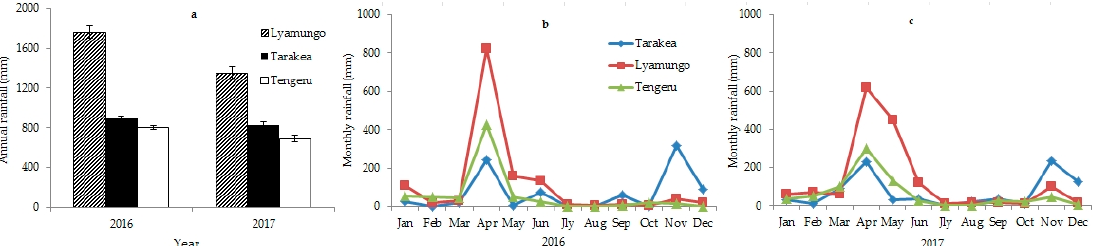
Figure 1. Annual rainfall ( a ) and rainfall distribution pattern ( b , c ) in the experimental sites located along the altitudinal gradients on the slopes of Mount Kilimanjaro and Mount Meru in northern Tanzania.